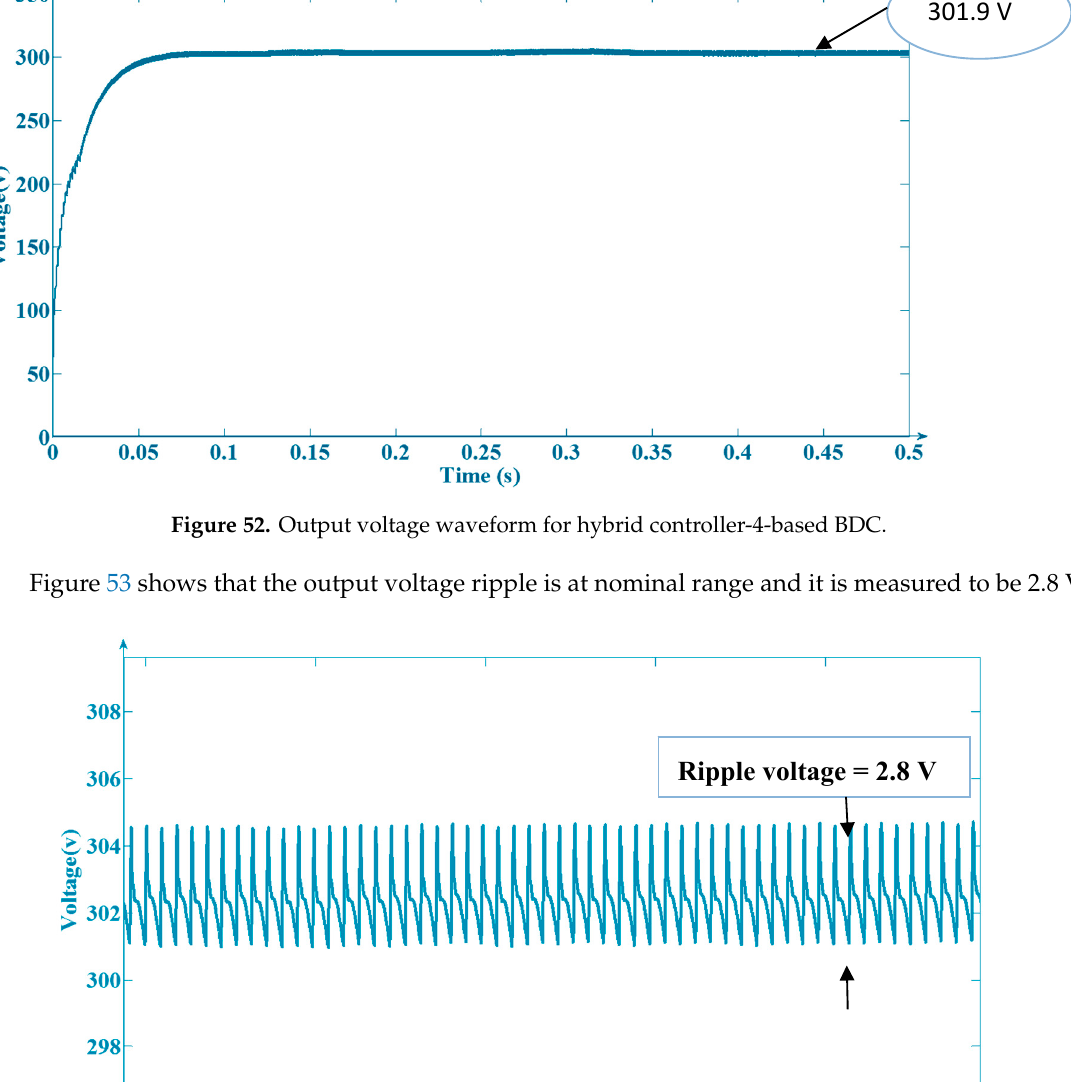
Figure 51. Multilevel output voltage waveform for MLI interfaced with hybrid controller-3-based BDC.